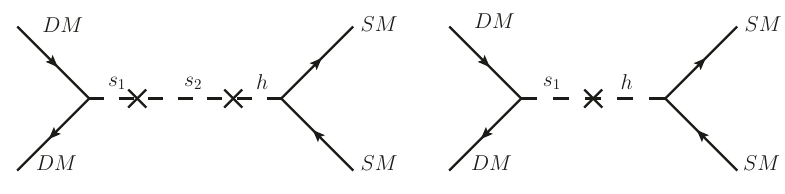
Figure 18 . Dark matter annihilation